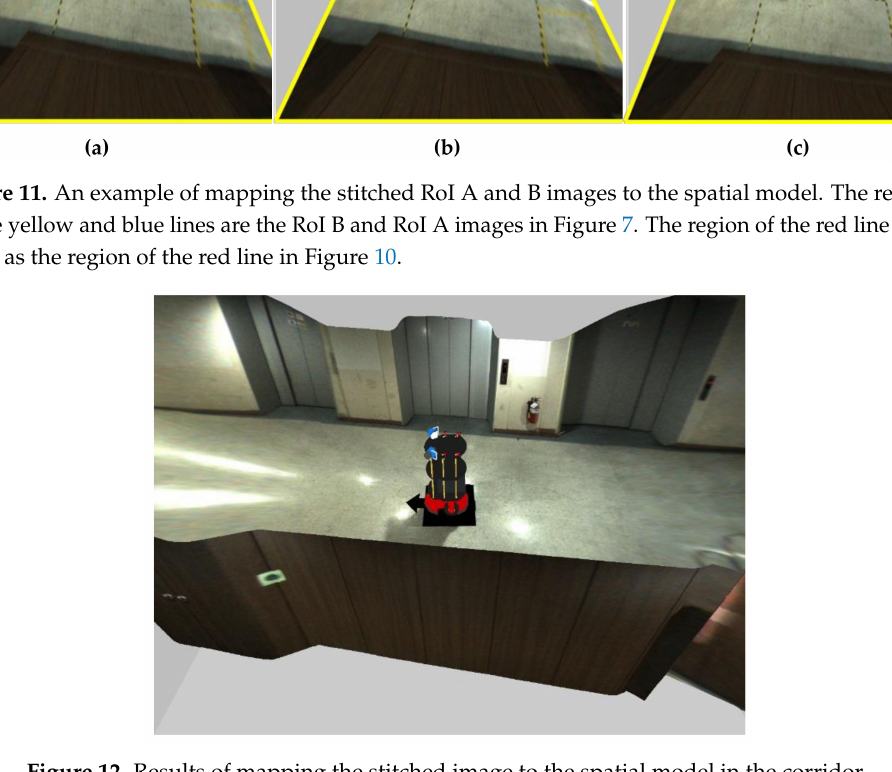
Figure 12. Results of mapping the stitched image to the spatial model in the corridor.